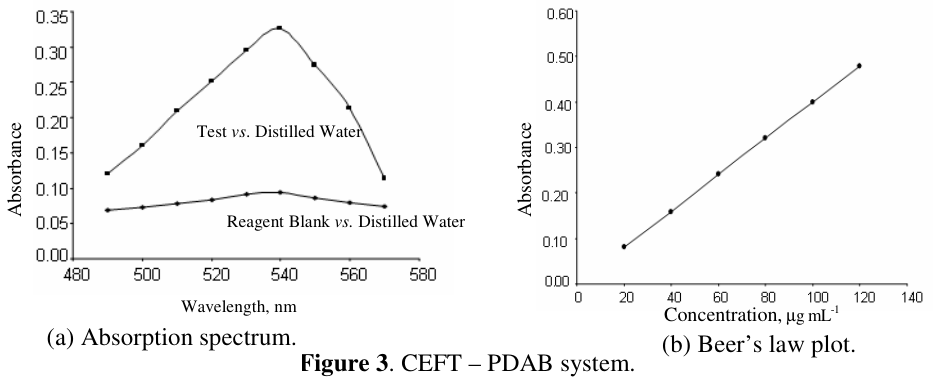
Figure 3 . CEFT – PDAB